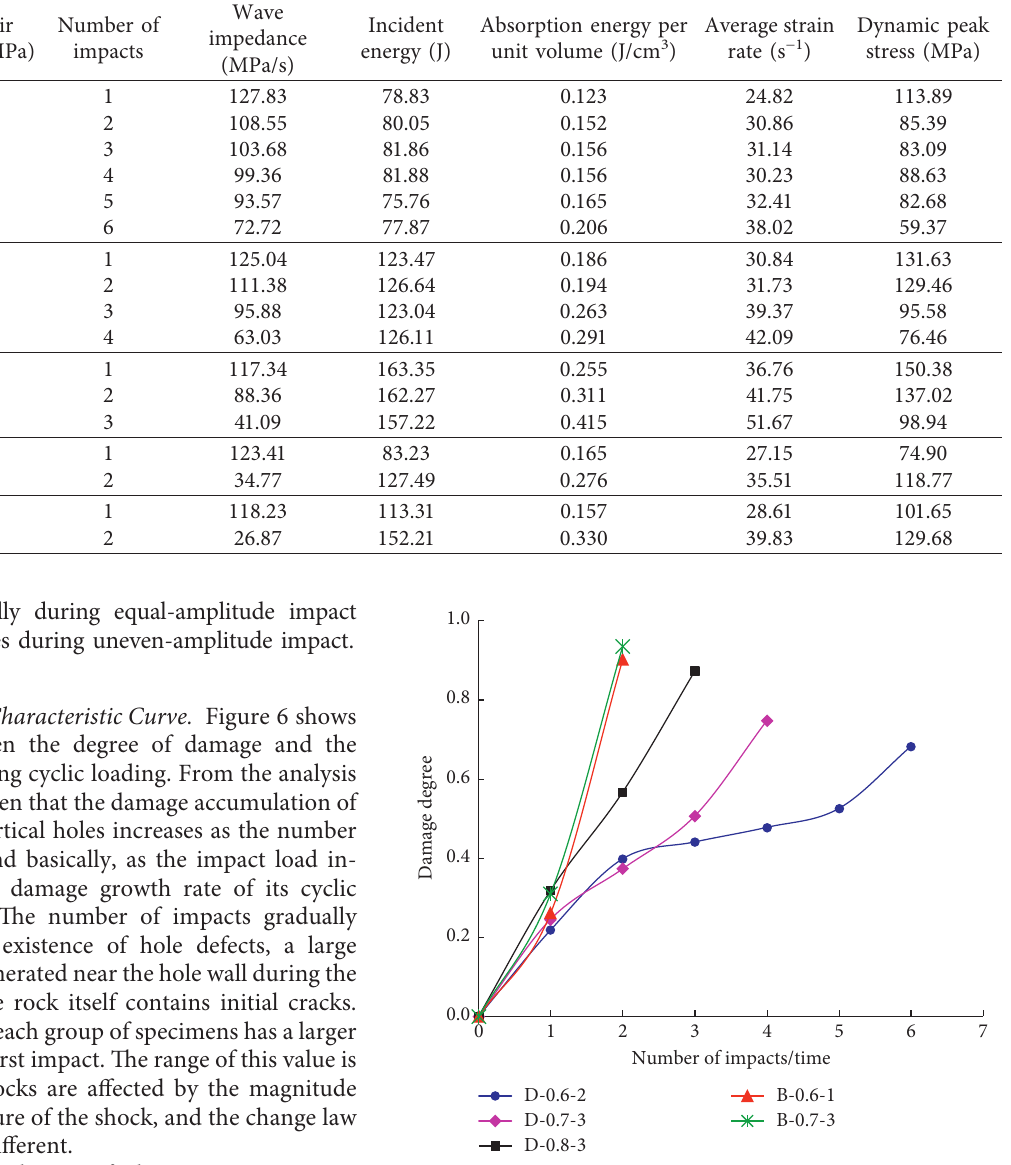
Table 2: Experimental results for some granite specimens under cyclical impact loads.